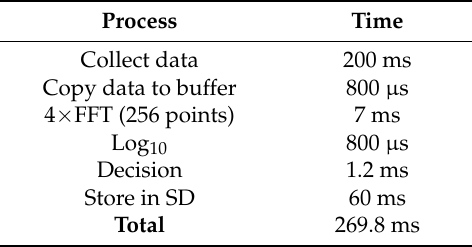
Table 1. Timing of events in